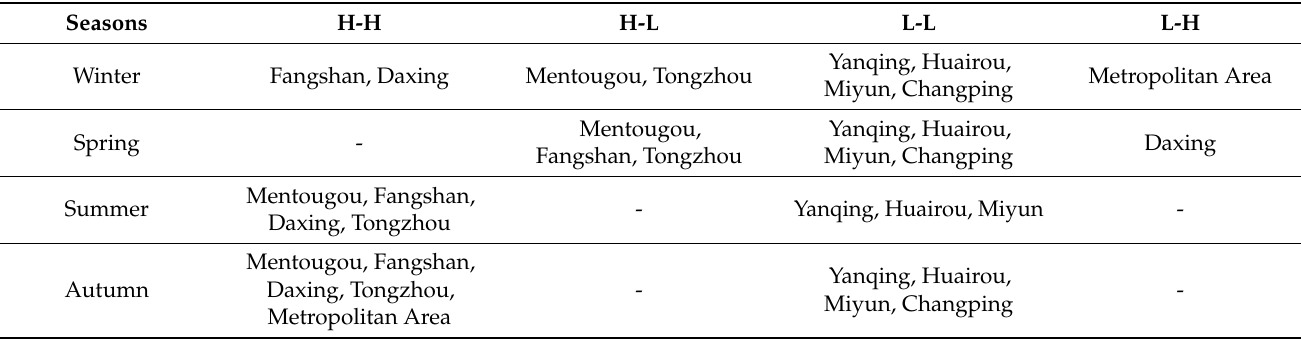
Table 5. Spatial correlation types of regions in different